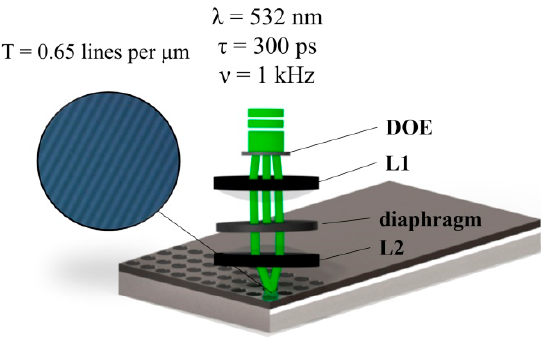
Figure 1. Scheme of the interference laser processing setup, where 300 ps laser pulses provided two-beam interference pattern on Ti film, where a typical pattern with a resolution of 0.65 lines per μ m can be obtained. Ti film oxidation was conducted under the irradiation with a fluence of 0.1–0.3 J/cm 2 with a different number of laser pulses ( N ) from 1 to 10 4 .